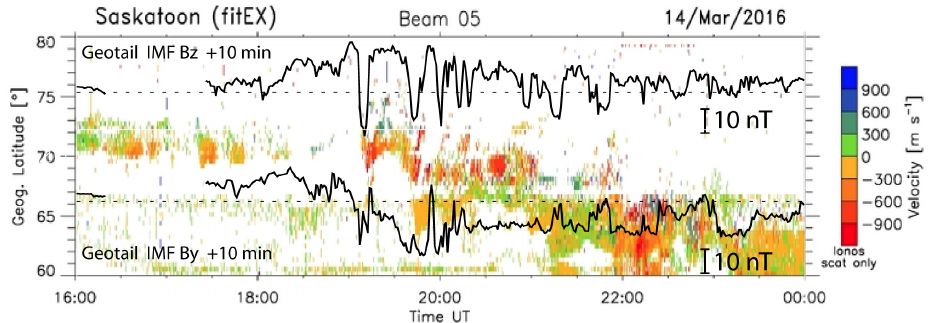
Figure 6. The Saskatoon radar line-of-sight velocities as a function of geographic latitude and time (UT). The time-shifted IMF B y and B z observed by Geotail are